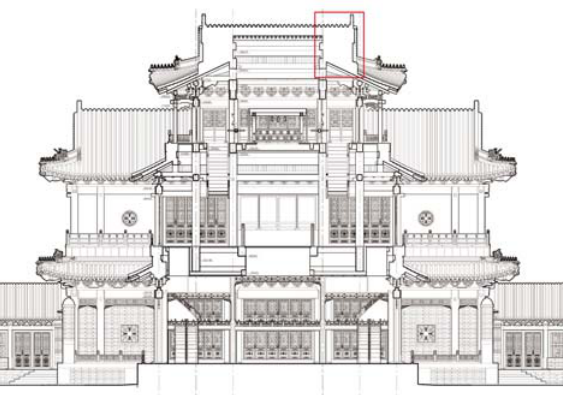
Fig.8. The section without hidden Parts of Daxi Lou